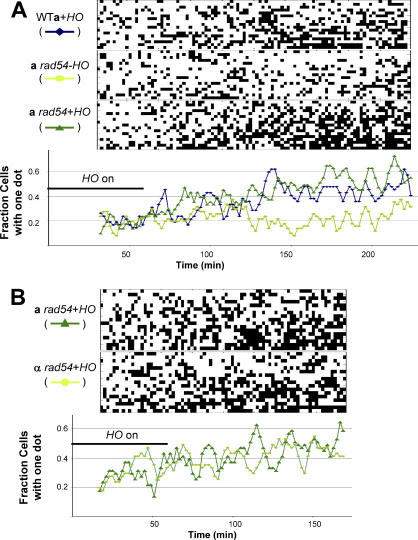
Rad54 Is Not Required for DSB-Induced Pairing of MAT and HML
Data were obtained and presented as described in Figure 2 for MAT
a
rad54 cells (A) and for MATα rad54 cells (B).